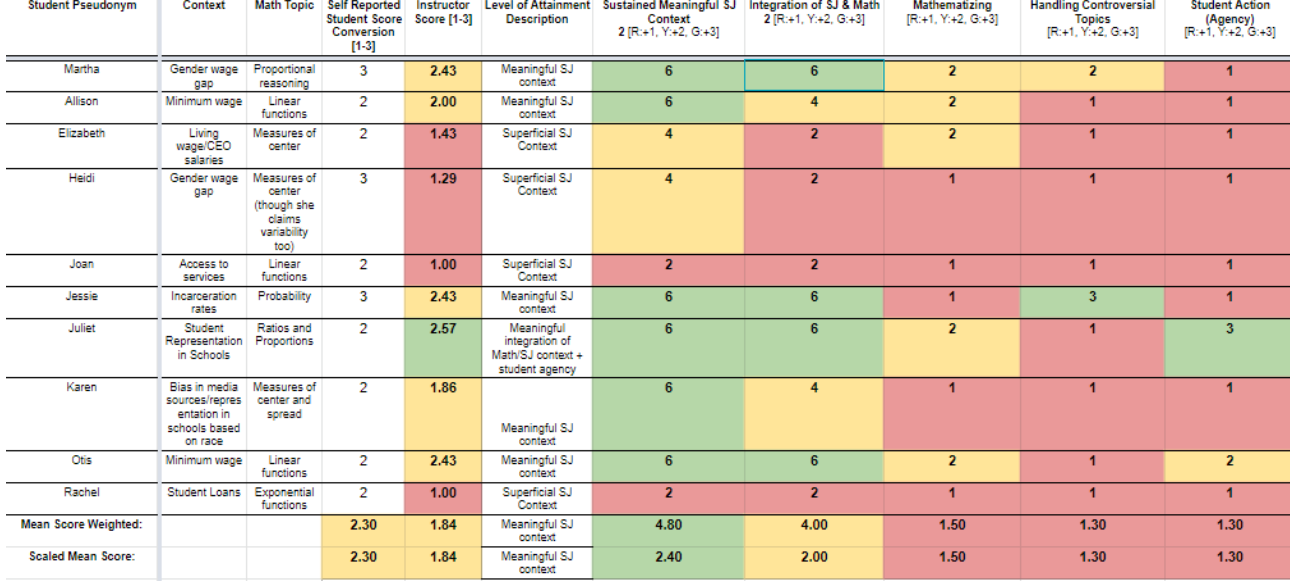
Figure A3. Final lesson plan analysis results for social justice element.